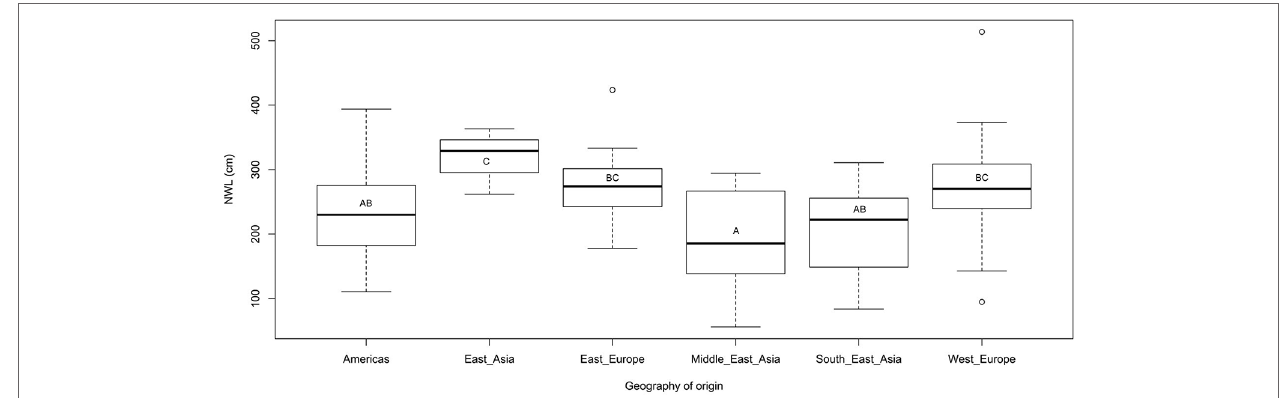
FIGURE 2 | Box plot showing variation in root network length among genotypes based on their geography or origin. Letter/s in the box indicate ( P < 0.05) after pairwise